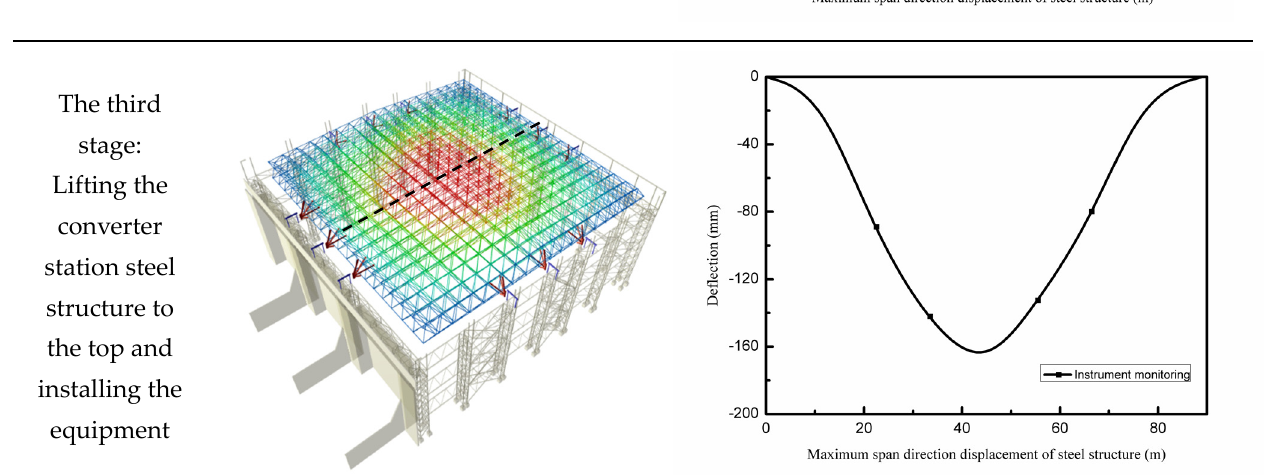
Table 4. The maximum deformation of the long-span converter station steel structure in the process of hoisting, consider- ing 17 levels of wind scale. Wind Scale